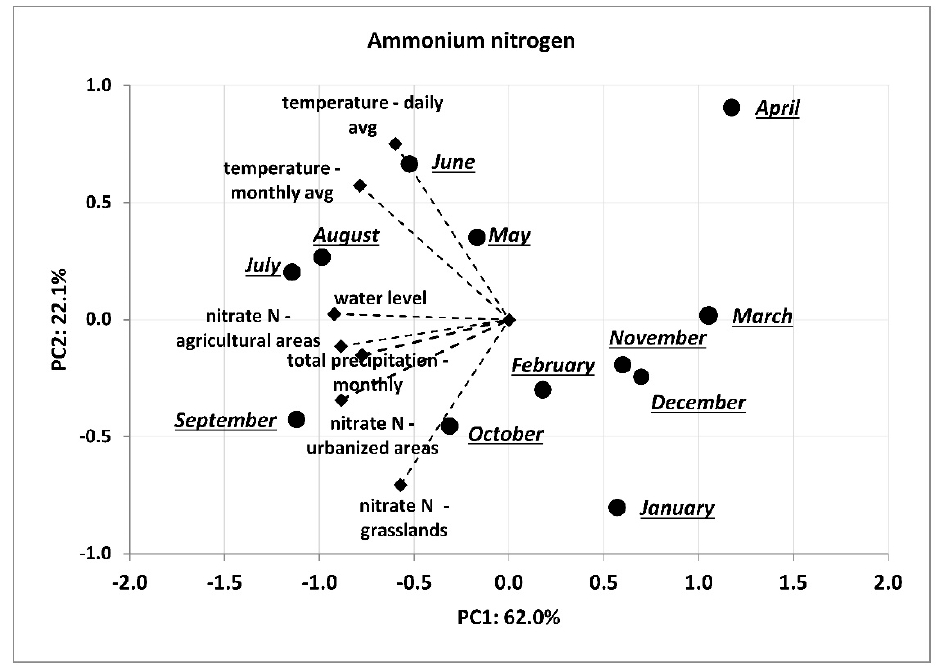
Figure 10. PCA analysis for the relationships between: catchment area land use, weather conditions and ammonium nitrogen concentration in the Utrata River.